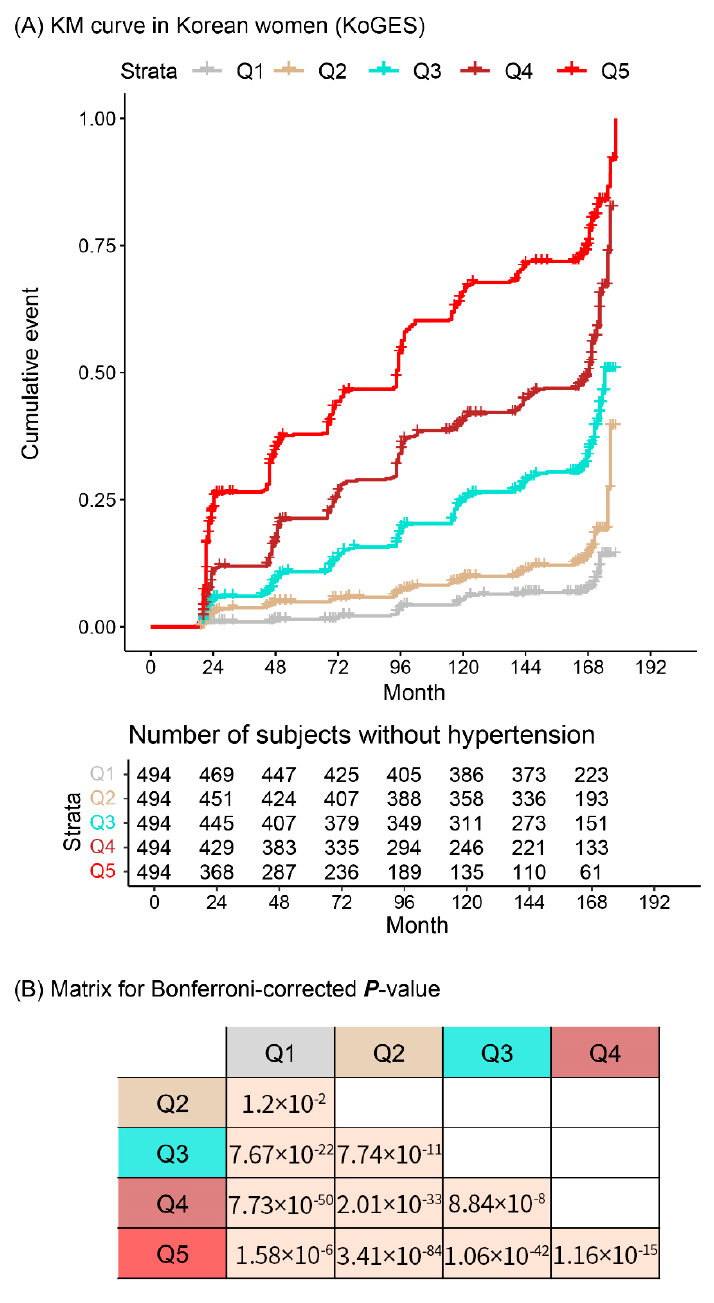
Figure 4. ( A ) Difference in cumulative incidences of new-onset hypertension between five groups divided according to the expected probabilities in women in the KoGES study. ( B ) p -value matrix. Abbreviations: KM, Kaplan–Meier; KoGES, Korean Genome and Epidemiology Study; Q, Quintile.